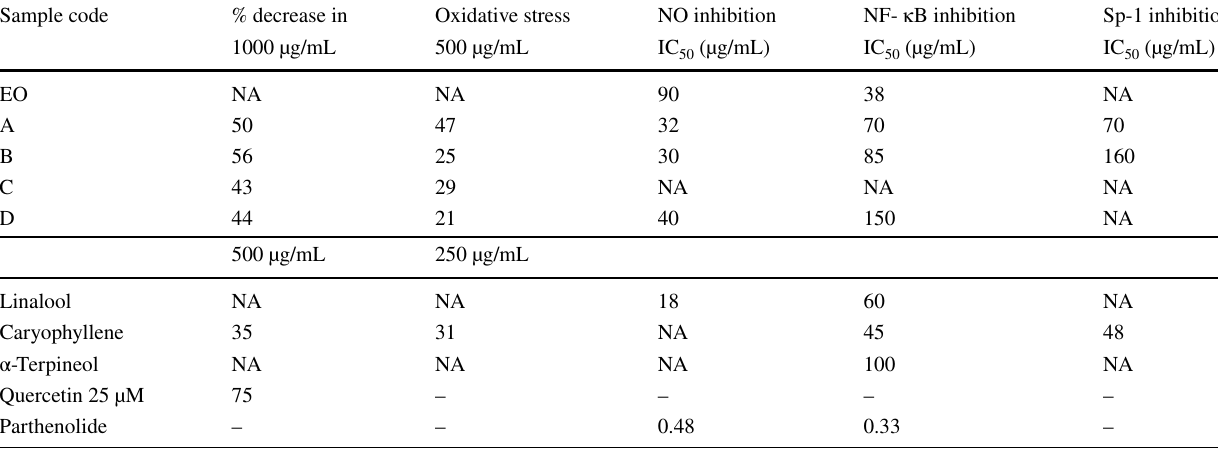
Table 3 Anti-inflammatory activity of S. ceratophylla essential oil, other extracts and pure compounds